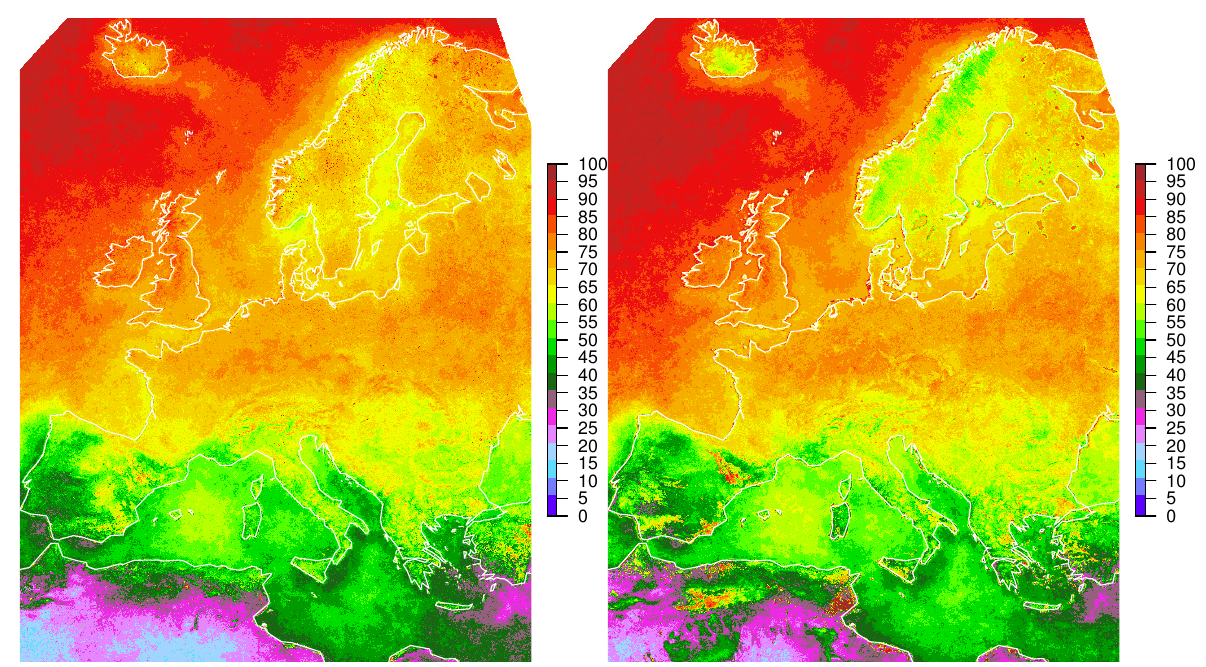
Fig. 9. PCM and PPS annual total cloud cover composites in 2008 derived from the collection of daytime NOAA18 scenes.